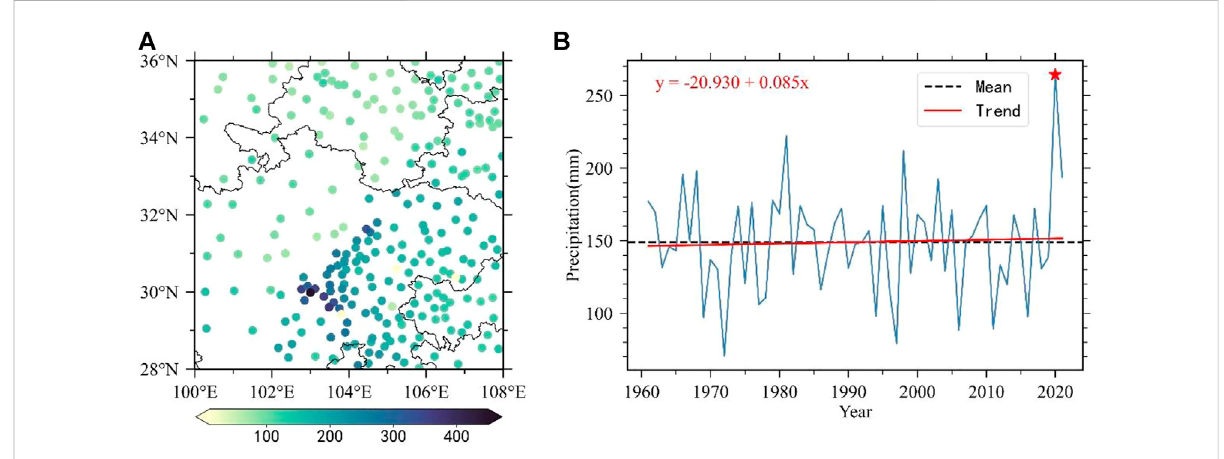
FIGURE 2 Spatial distribution of the climatology (A) precipitation distribution and (B) the station-averaged precipitation series in August during 1961 – 2021 in WC (Dashed black line and the red solid line represent the climatological mean and linear trend, respectively. Unit: